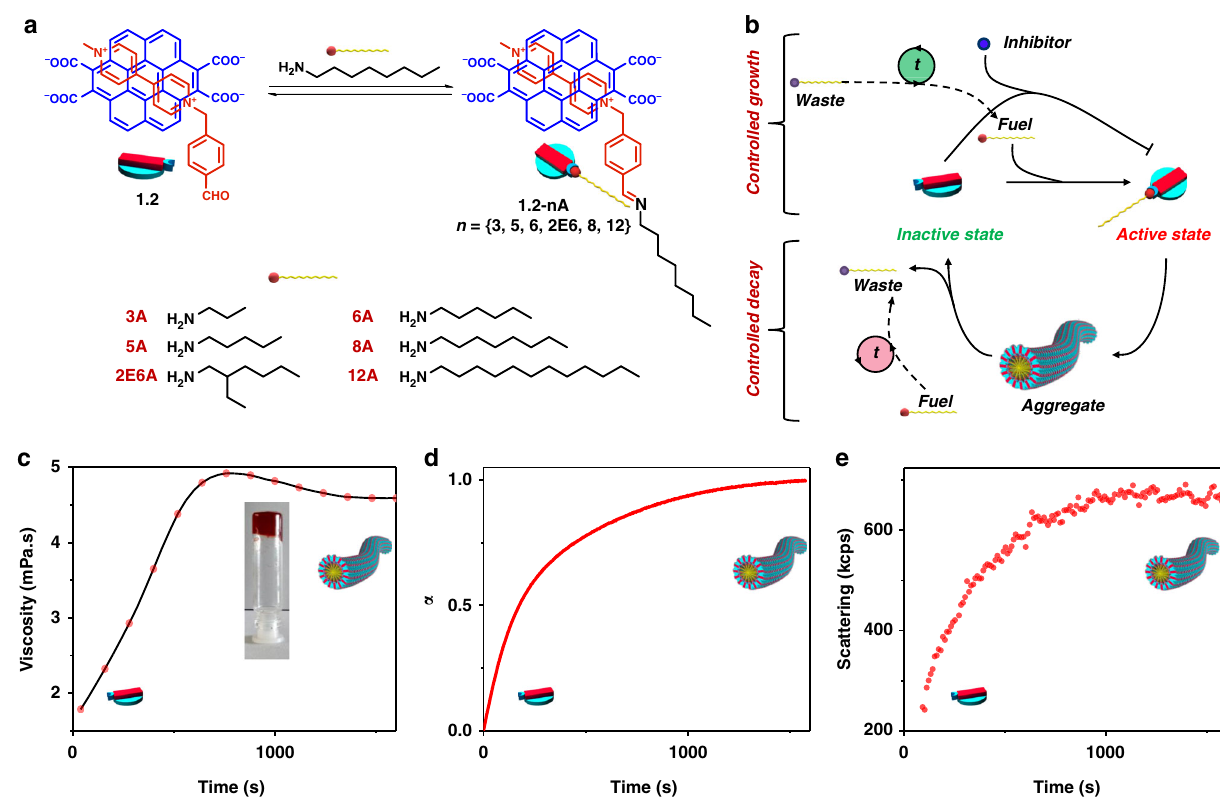
Fig. 1 Molecular structure of the monomers and their growth kinetics. a Molecular structures of a charge-transfer complex ( 1.2 ) between aromatic donor 1 , and benzaldehyde substituted viologen acceptor 2 , along with various alkyl amines used in this study. b Schematic illustration of the reaction-driven temporal control of supramolecular polymerization of 1.2 . c – e Time-dependent evolution of viscosity trend, absorption trace at 515 nm, and scattering respectively monitored for the kinetics of formation of 1.2-8A . Inset in c is the photograph of hydrogel of 1.2 - 8A (10 mM). α is the extent of self-assembly (For c – e : [ 1 ] = [ 2 ] = [ 8A ] = 1 mM, pH =